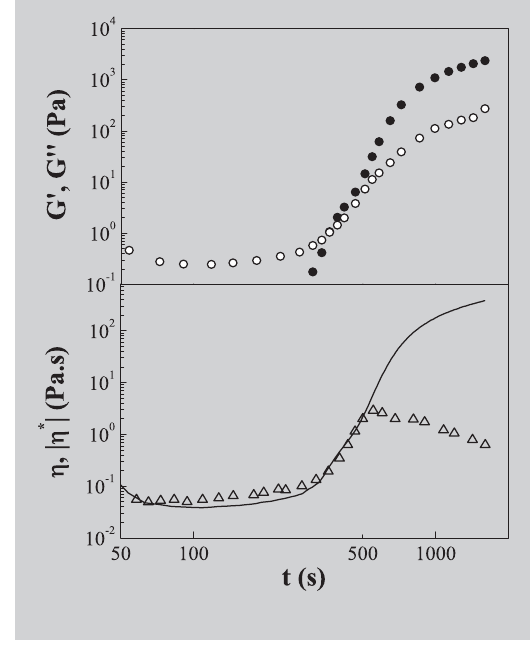
Figure 1: Time dependence of the storage ( Ê ) and loss ( Á ) shear moduli (top) during small amplitude oscillation shear and the viscosity (Δ) (bottom) during shear flow at 10 s -1 for a submicelle solution at C = 80 g/L heat- ed at 80ºC. The solid line in the bottom figure figure represents the dynamic vis- cosity calculated from the small amplitude oscillation measurements shown in the top